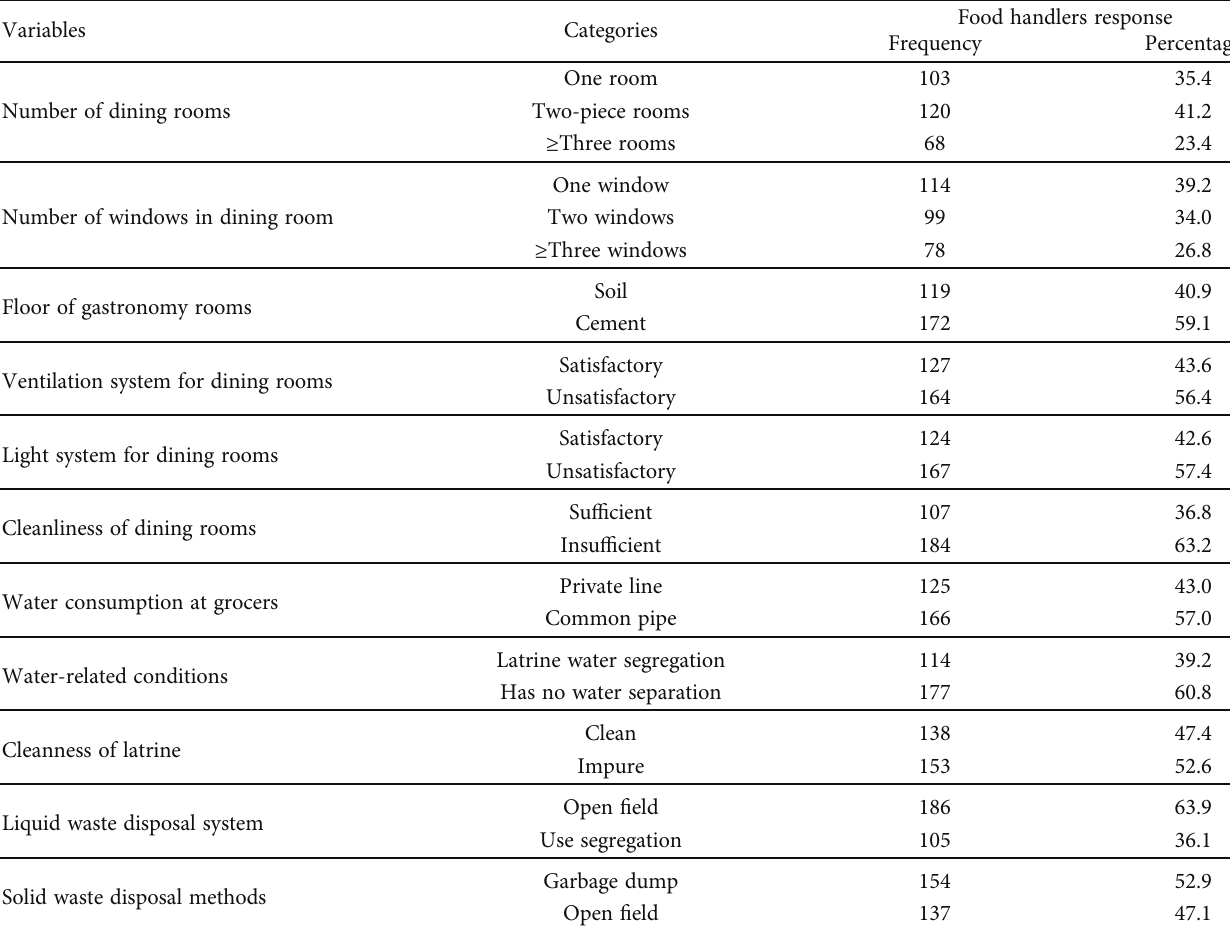
Table 3: Physical sanitary conditions of food premises at Woldia University students ’ canteen, May – July 2021 ( n = 291 ).